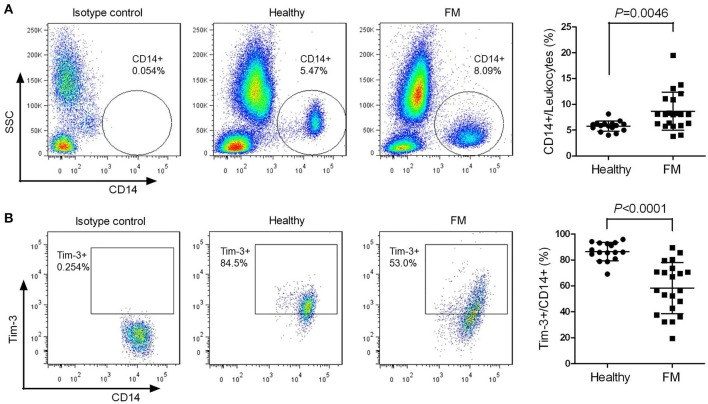
Decreased T-cell immunoglobulin- and mucin-domain-containing molecule 3 (Tim-3) expression in monocytes from falciparum malaria (FM) patients. Peripheral blood from 21 patients with FM and 16 healthy individuals (Healthy) were analyzed by flow cytometry. (A) Representative dot plots (left panels) and a scatter plot (right panel) showing the proportion of CD14+ cells relative to the total leukocyte populations. (B) Representative dot plots (left panels) and a scatter plot (right panel) showing the frequency of Tim-3-expressing cells in the CD14+ cell populations. Each dot in the scatter plot represents one individual, with horizontal lines indicating the mean ± SD.